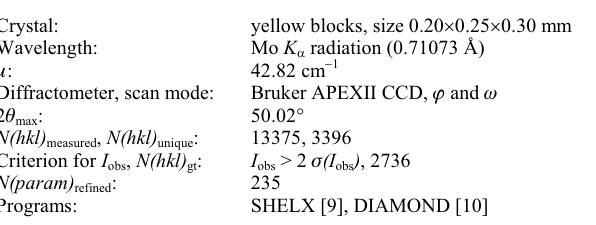
Table 2. Atomic coordinates and displacement parameters (in Å 2 )